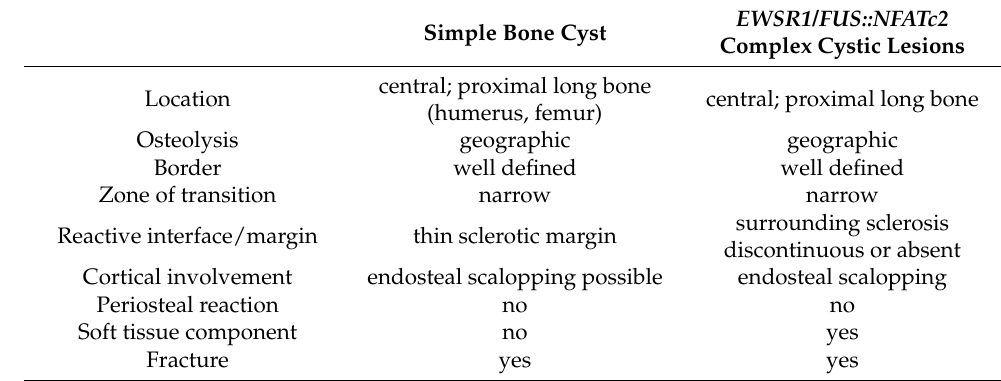
Table 2. Comparison of radiographic characteristics between a simple bone cyst and our two EWSR1/FUS::NFATC2 cystic bone lesions. EWSR1/FUS::NFATc2 Simple Bone Cyst Complex Cystic Lesions central; proximal long bone central; proximal long bone Location (humerus, femur) Osteolysis geographic geographic Border well defined well defined Zone of transition narrow narrow surrounding sclerosis Reactive interface/margin thin sclerotic margin discontinuous or absent Cortical involvement endosteal scalopping possible endosteal scalopping Periosteal reaction no no Soft tissue component no yes Fracture yes